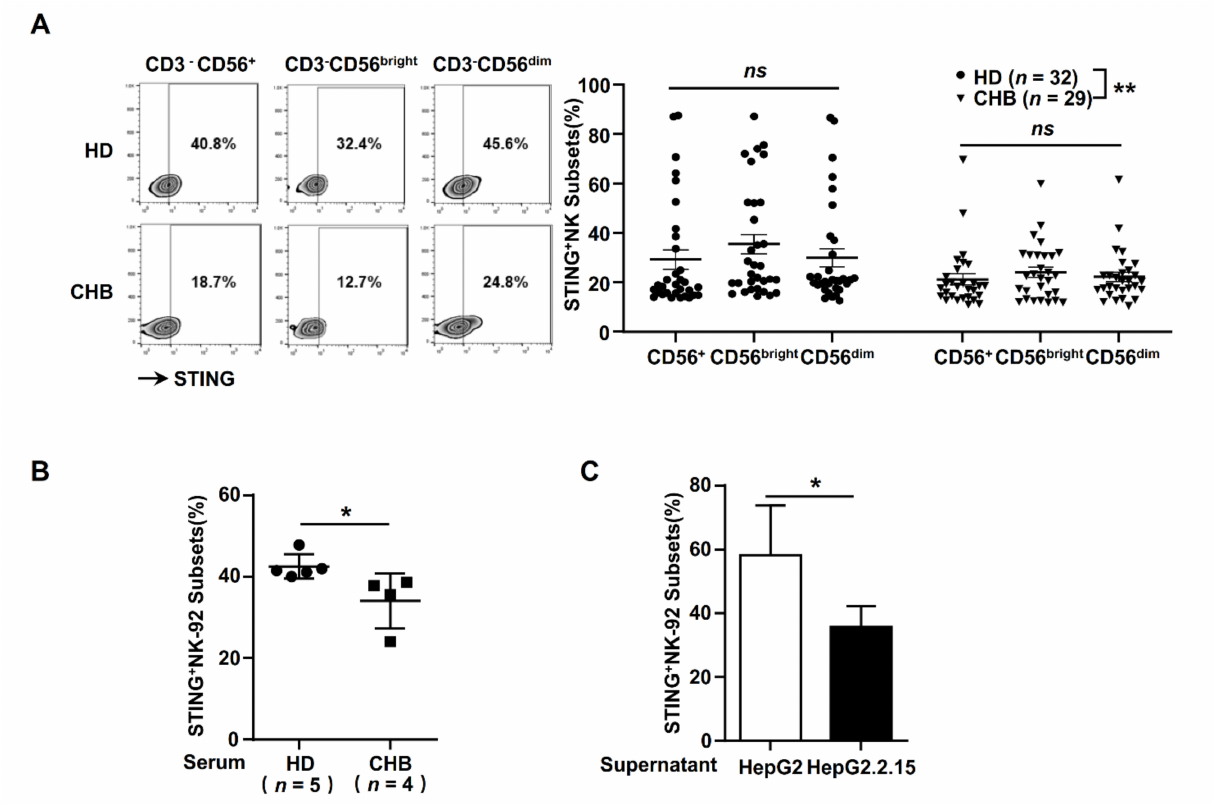
Figure 1. The STING level of NK cells was significantly decreased in CHB patients. ( A ) The ratio of peripheral STING + NK cells (CD3 - CD56 + , CD3 - CD56 bright and CD3 - CD56 dim cells) in CHB patients and HDs. The statistically significant difference between HD and CHB was determined by a two-way ANOVA. ( B ) STING expression of NK-92 cells were analyzed by flow cytometry, after incubation with serum of HD and CHB patients for 48 h. The serum was diluted with 20 times culture medium of NK-92 cells. ( C ) STING expression of NK-92 cells were analyzed by flow cytometry after incubation with supernatant of HepG2 and HepG2.2.15 for 48 h. Data are shown as the mean ± SEM. The statistically significant difference between two groups was determined by a t -test. ns, p > 0.05; * p < 0.05; ** p < 0.01. CHB, CHB patients; HD, healthy donors; NK, natural